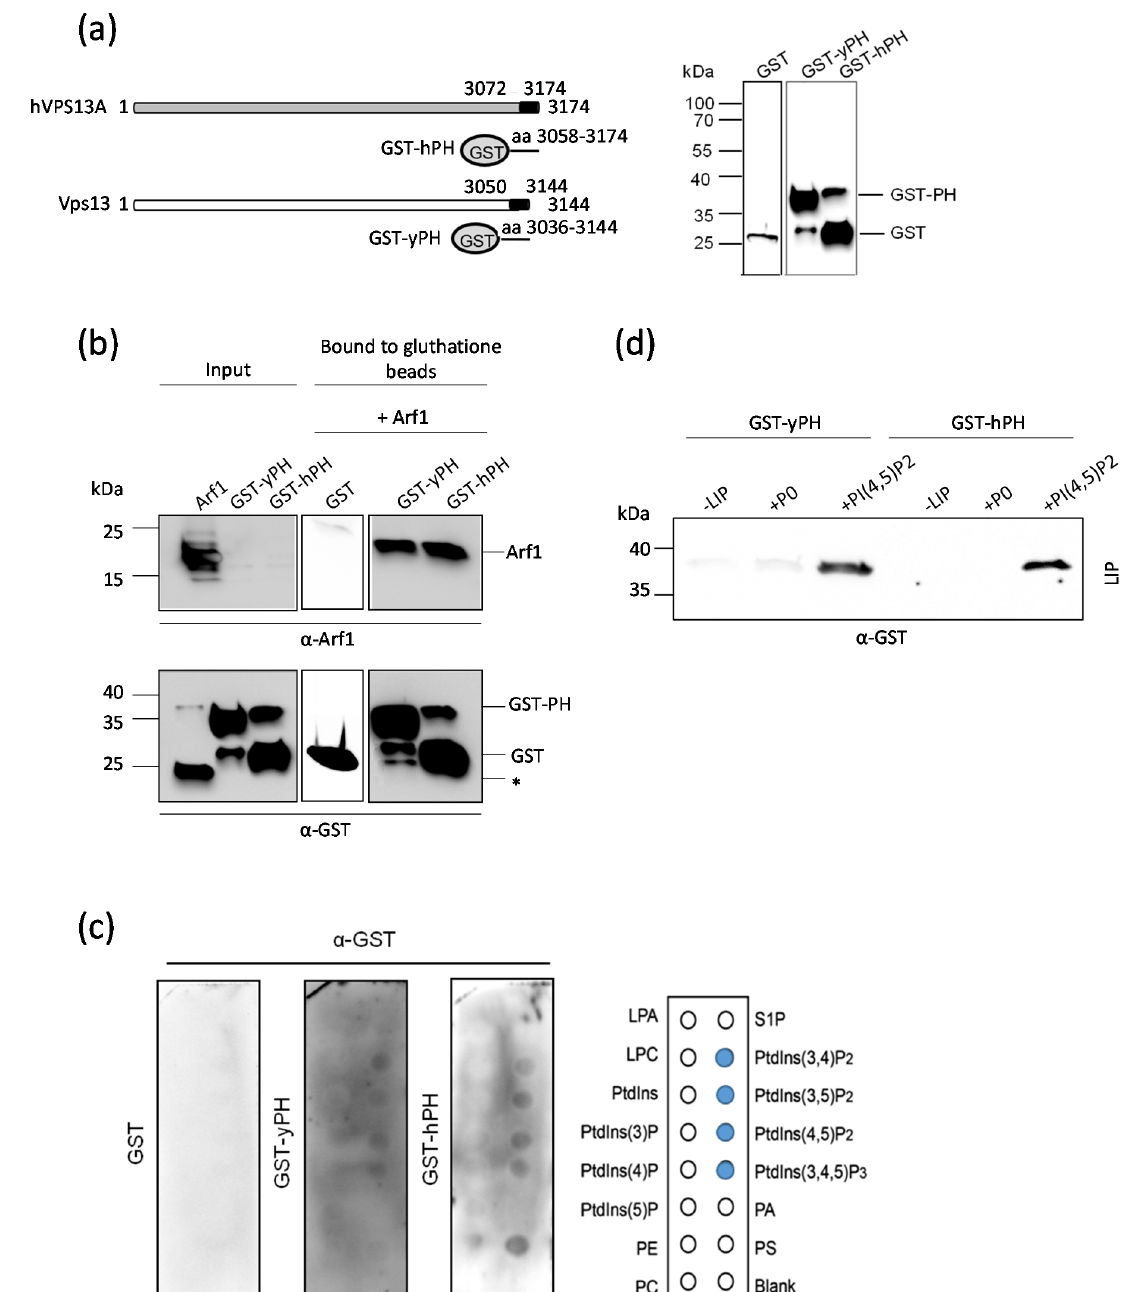
Figure 4. The interaction of PH-like domains from Vps13 and VPS13A with Arf1-GTP and selected phosphatidyl inositol phosphates in vitro. ( a ) Schematic representation of Vps13 and VPS13A and the fragments fused to GST that were used to test the binding to Arf1 GTPase and to lipids. The yPH and hPH domains are colored black. Western blot analyses of GST-yPH and GST-hPH purified from bacteria are shown in the right-hand panel. ( b ) Purified recombinant GST-yPH and GST-hPH or GST alone were bound to glutathione beads before the addition of recombinant Arf1. The purified proteins used in the experiment (input) and proteins bound to glutathione beads were analyzed by Western blot using α -Arf1 and α -GST antibodies; *—Non-specific band. ( c ) Analysis of lipid binding by yPH and hPH domains. Purified GST-yPH and GST-hPH proteins (1 µg each) were used to analyze the interaction with phospholipids on membranes by protein lipid overlay assay. Lipid-bound proteins were detected by Western blot using α -GST antibodies. GST protein was used as a negative control. ( d ) The yPH and hPH domains bound to liposomes enriched in PI(4,5)P 2 . Purified GST-yPH and GST-hPH proteins were incubated without liposomes (-LIP), with biotinylated liposomes without PIPs (P0) and with liposomes enriched with 5% PI(4,5)P 2 (+PI(4,5)P 2 ). Liposomes were collected using streptavidin-coated beads. Binding of proteins to liposomes was analyzed by Western blot using α -GST antibody (LIP).